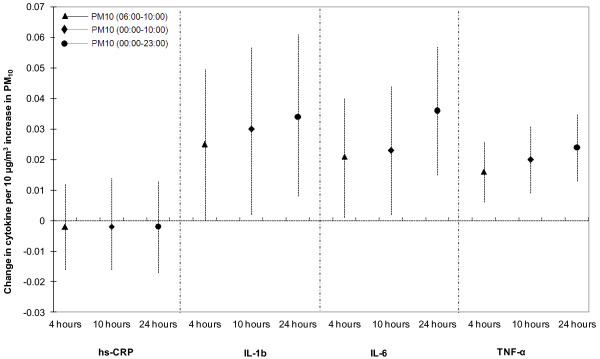
Association between different time-averaged PM10concentrations and log-transformed inflammatory markers (adjusted effects).